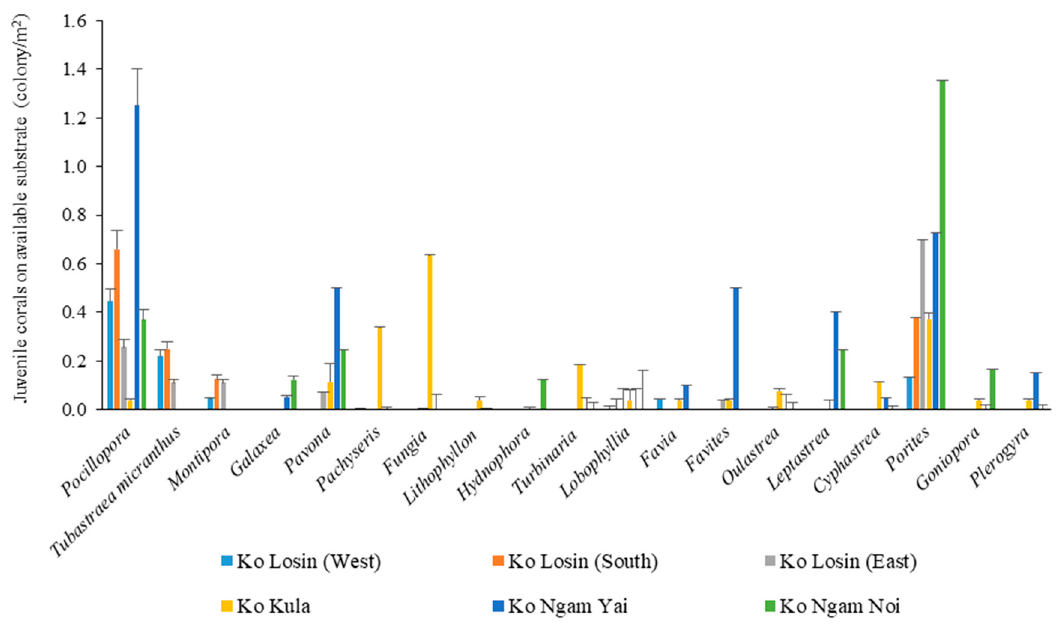
Figure 10. Composition of the juvenile corals on available substrate at the study sites. Error bars indicate standard deviation.